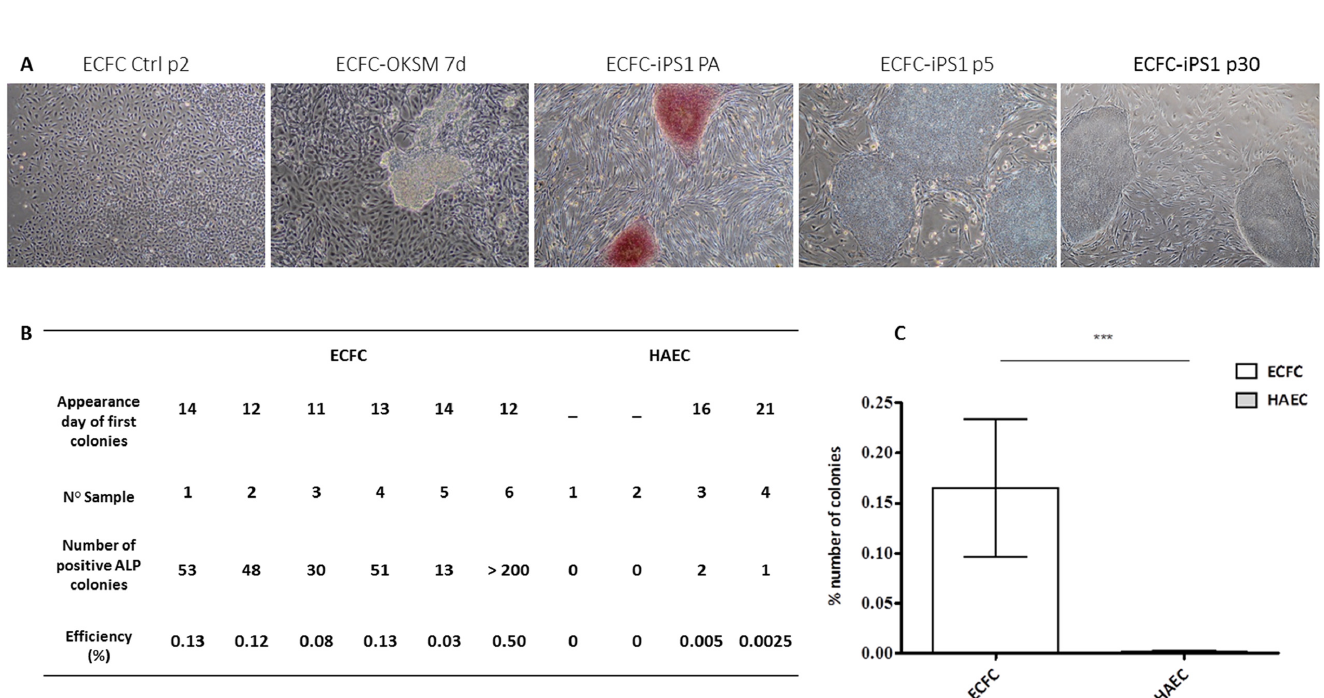
Fig 2. Morphology of ECFC-derived iPSCs and reprogramming efficiency of ECFCs and HAECs. (A) Cobblestone morphology of ECFCs before and 7 days after transduction, ECFC morphology changed and colonies were ALP positives. At passage 5 and 30, ECFC-derived iPSC1 showed typical characteristics of hESC colonies. (B-C) ECFC and HAEC reprogramming efficiency and rate. The reprogramming efficiency was estimated based on the number of ALP positive colonies. Error bars represent SEM ( *** p < 0.005).